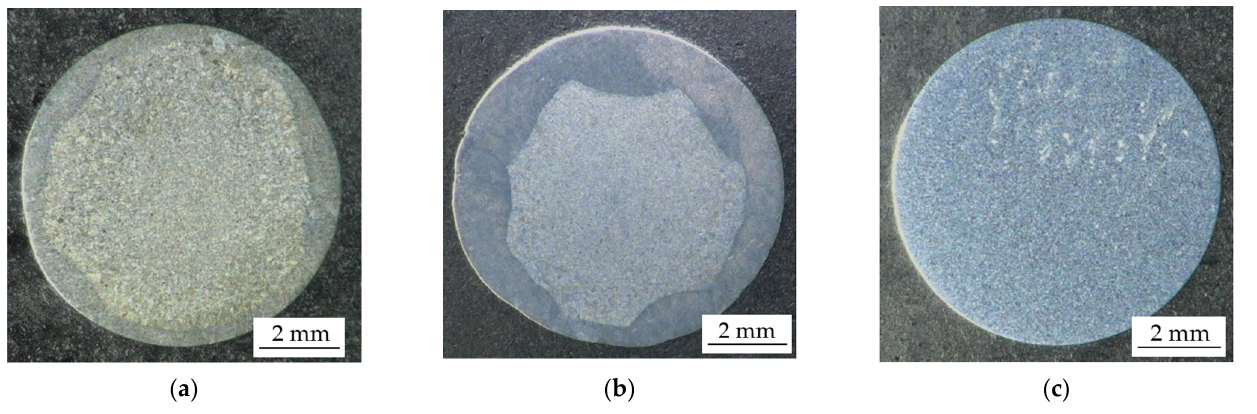
Figure 6. Cross-sections of turbocharger shaft journals. Single-layer coating ( a ), double-layer coating ( b ), new shaft journal ( c ). The specimens were etched with Kalling’s reagent; 3× magnification.